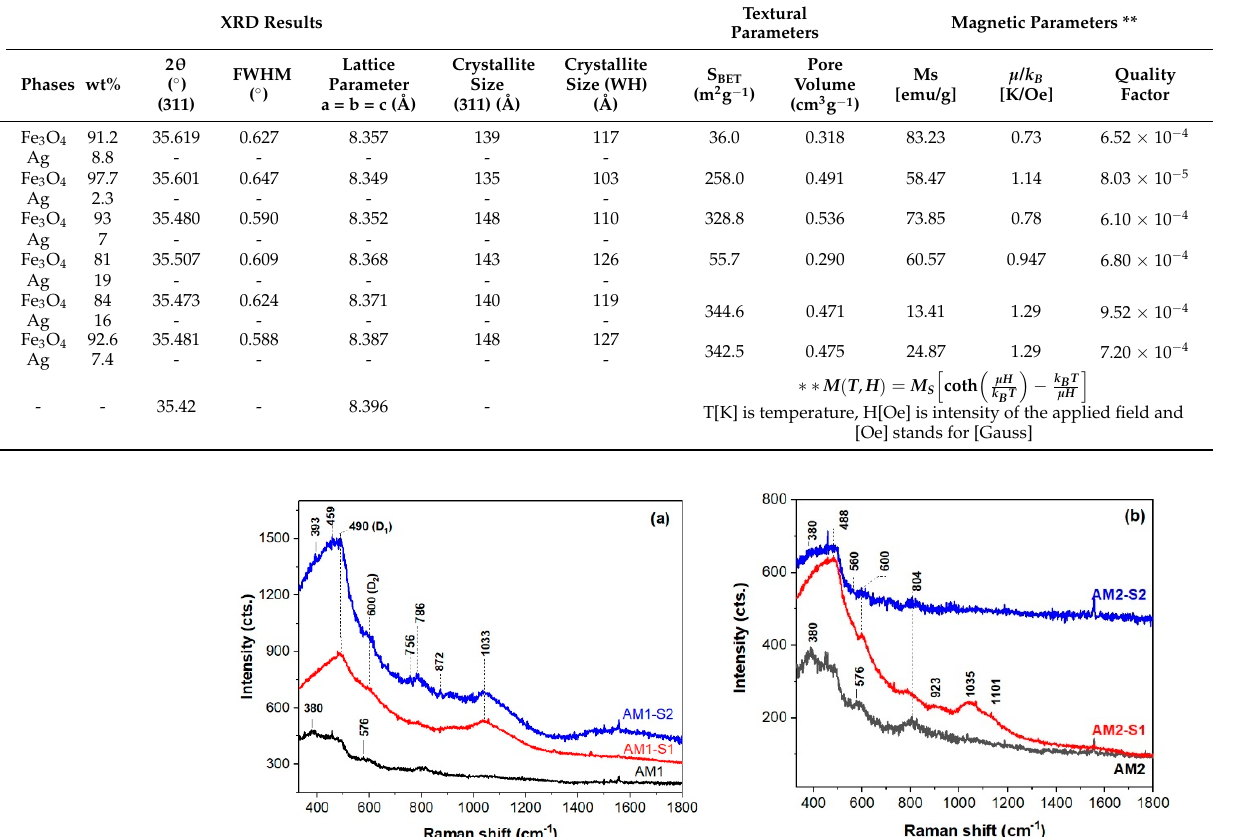
Table 1. Structural and physical parameters of investigated MNPs.